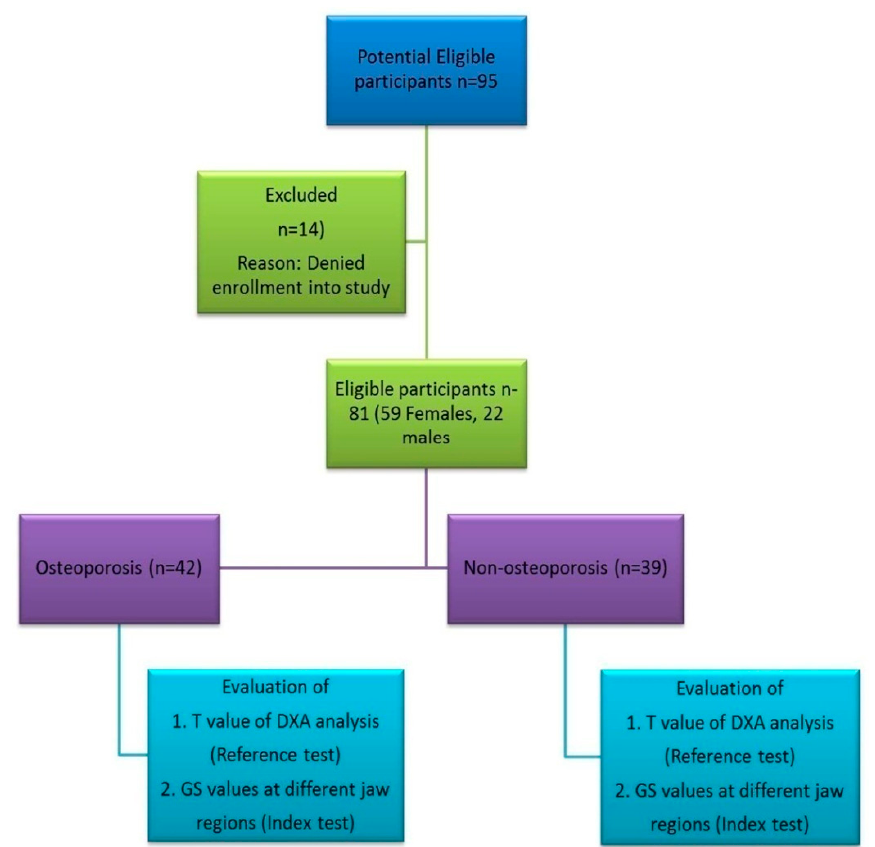
Figure 3. STARD Flow diagram.